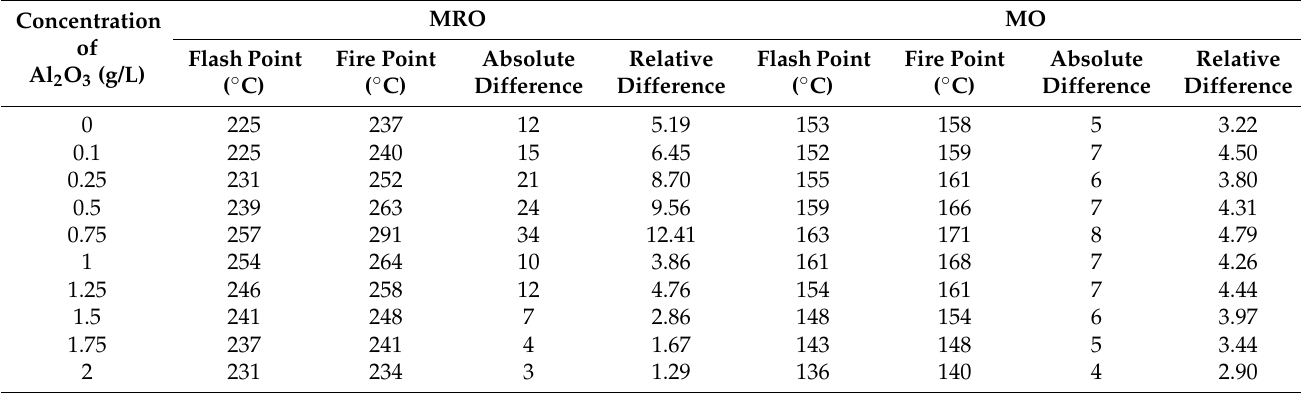
Table 8. Flash and fire points of MRO and MO under various concentration of Al 2 O 3 .